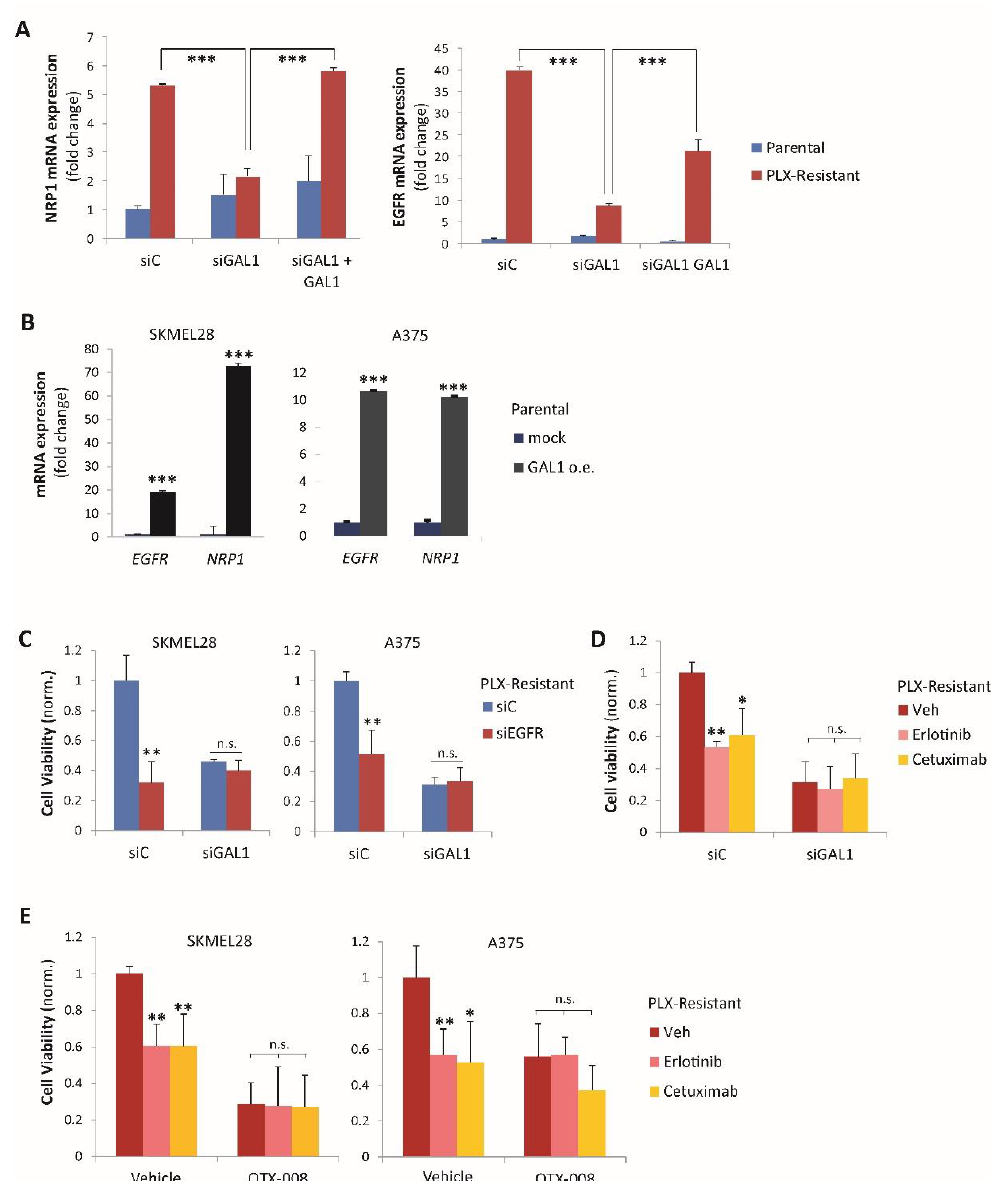
Figure 4. Galectin-1 promotes NRP1 and EGFR expression. ( A ) The qPCR analysis of NRP1 (left) and EGFR (right) mRNA levels in parental or PLX-4720-resistant A375 cells, either control or subjected to Galectin-1 silencing, in the presence or absence of recombinant Gal-1 at a concentration of 1 µ g / mL ( n = 3). The statistical significance was assessed by t -test; *** p < 0.0005. Figure S3A shows consistent results obtained in the SK-MEL-28 cell model. ( B ) The qPCR analysis of NRP1 and EGFR mRNA levels in SK-MEL-28 and A375 parental cells transfected with cDNA encoding Galectin-1 (GAL1 overexpressing, o.e.) or mock. The statistical significance was assessed by t -test by comparing the expression of the indicated genes in Gal-1 transfected vs. control cells; *** p < 0.0001. ( C ) Viability of SK-MEL-28 and A375 melanoma cells resistant to PLX-4720 (and maintained in the presence of the drug), subjected to Gal-1 knock-down (siGAL1) or control (siC), and further subjected (or not) to EGFR targeting with siRNA (siEGFR; achieving 0.3-fold average knock-down verified by qPCR). The statistical significance was assessed by t -test by comparing siEGFR-treated condition with the respective control conditions; ** p < 0.005. ( D ) The viability of A375 melanoma cells resistant to PLX-4720 (in the presence of the drug), either subjected to Gal-1 knock-down (siGAL1) or control (siC), was assessed upon co-treatment with the indicated EGFR inhibitors (erlotinib 100 nM or cetuximab 1 µ g / mL) or with the vehicle